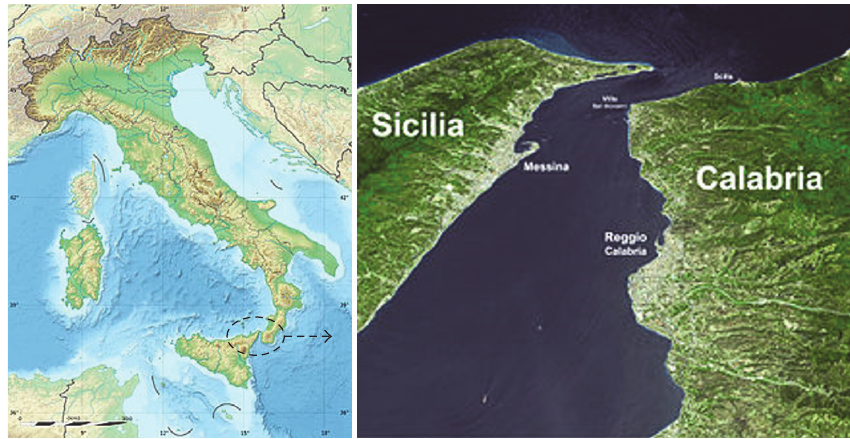
Figure 6: Location of the proposed application (images from Wikipedia).